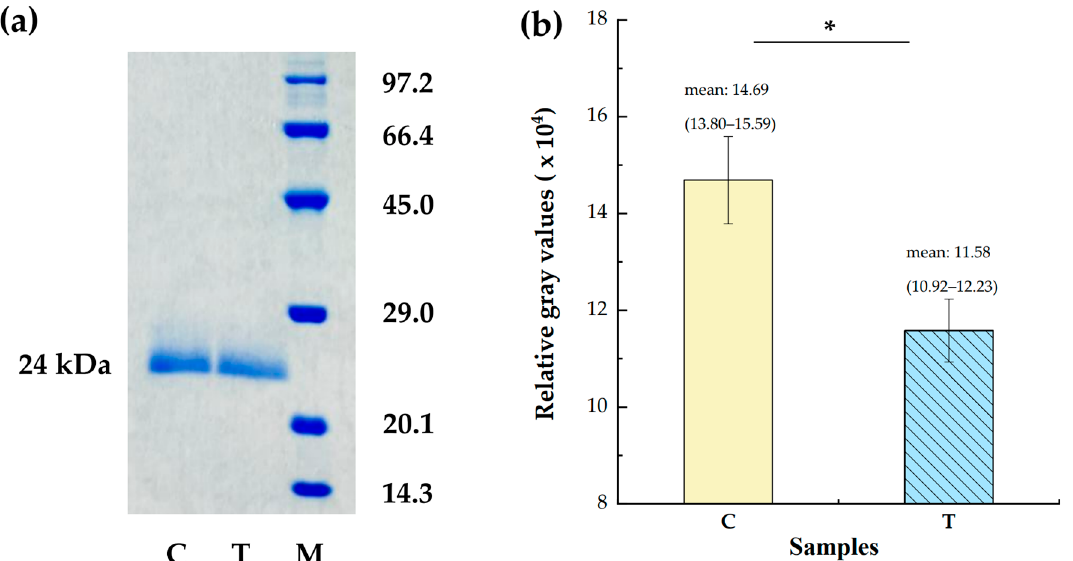
Figure 2. Reduced level of standard allergen Der f 1 exposure to todomatsu oil atmosphere was determined through SDS-PAGE. ( a ) Graph from SDS-PAGE; ( b ) Quantification for SDS-PAGE results. The standard allergen Der f 1 (100,000 ng/mL) exposure to todomatsu oil atmosphere (0.10 µ L/cm 3 ) for 2 h at 25 °C was designated as the test group, and the oil-free duplication was set as a control group. The value is the mean (minimum-maximum) from two independent replicates of each sample. C: control group; T: test group; M, marker. * signifies a significant difference ( p < 0.05).